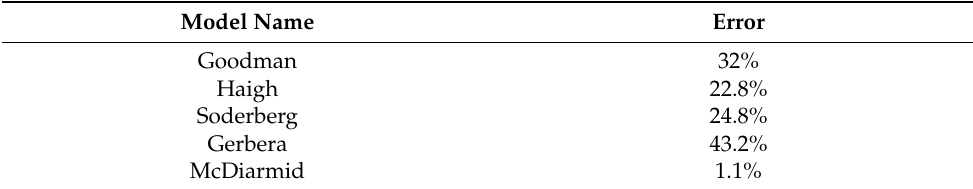
Table 9. Errors of the predictions. Model